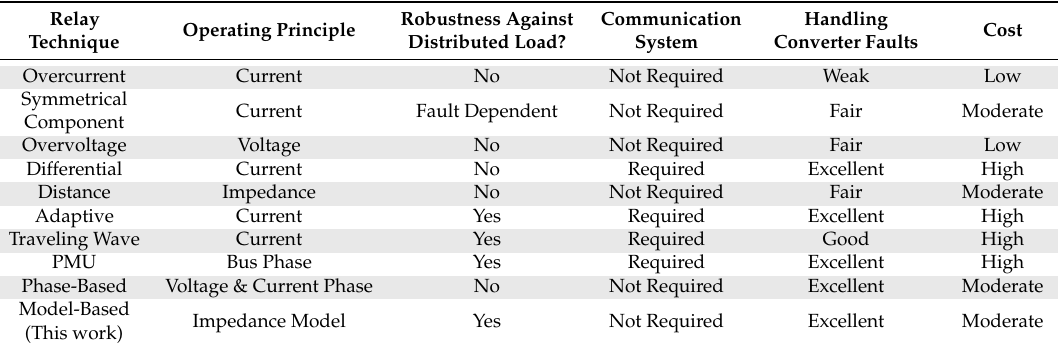
Table 1. Qualitative comparison of general classes of relay protection